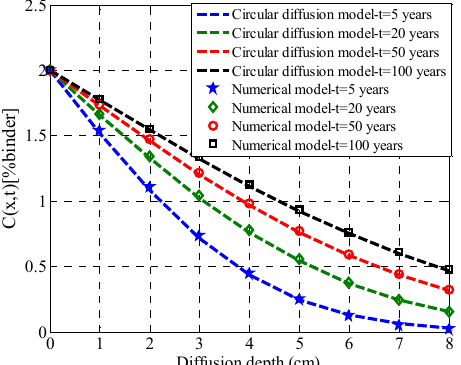
Figure 2. A comparison between the circular diffusion and numerical models.